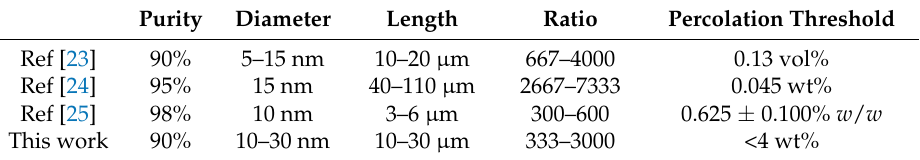
Table 1. Parameters of the carbon nanotubes’ (CNTs) PDMS composites.